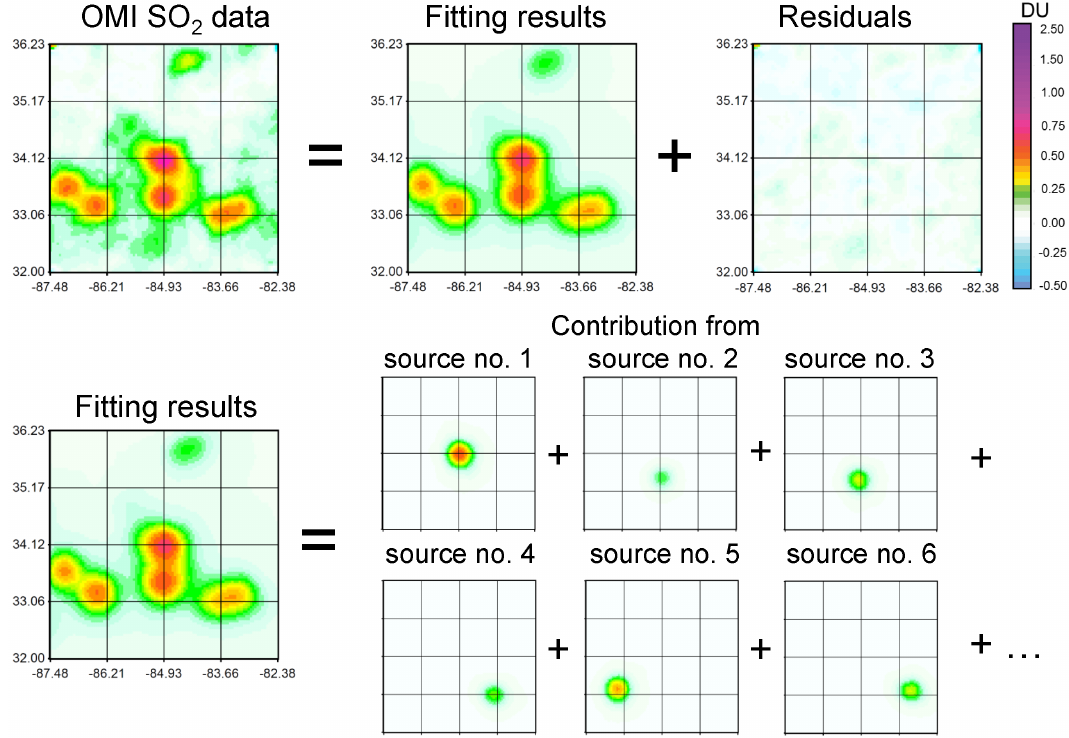
Figure A1. Fitting OMI data near the Bowen power plant in Georgia, US, 2005–2007. All sources with emissions > 20ktyr − 1 were included in the